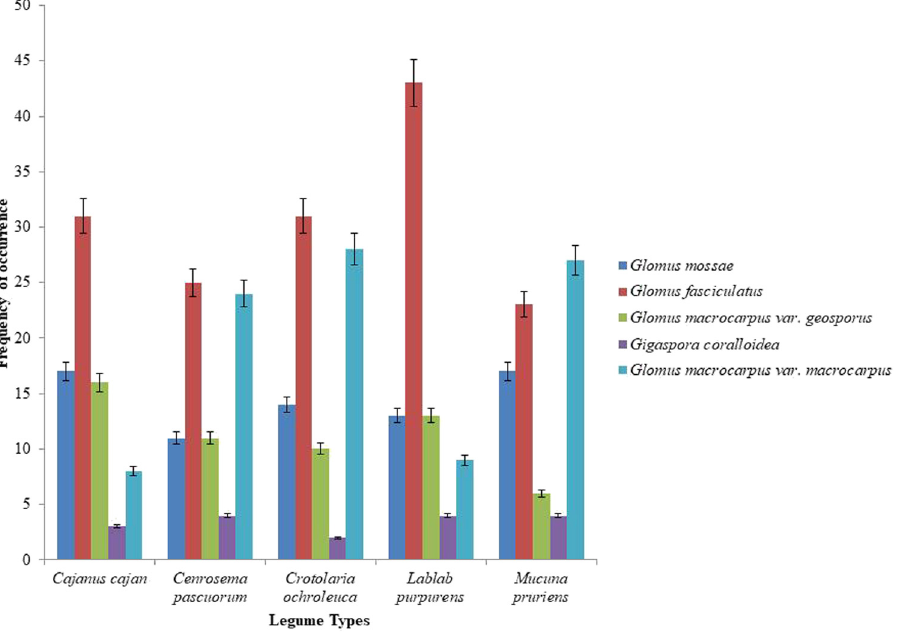
Figure 1: Percentage frequency of occurrence of predominant AMF spores in the soil of studied legume species. Bars are % error